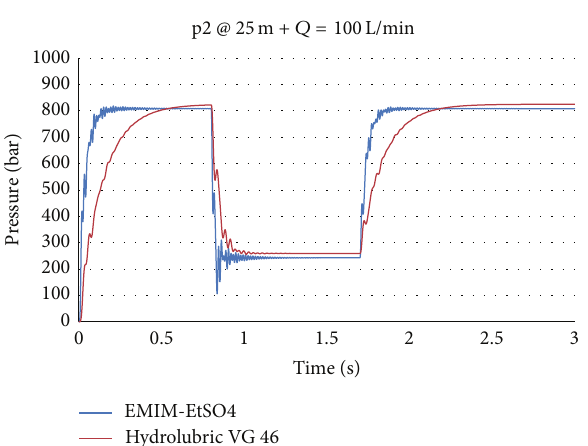
Figure 9: Dynamic of pressure changes by using mineral hydraulic oil and